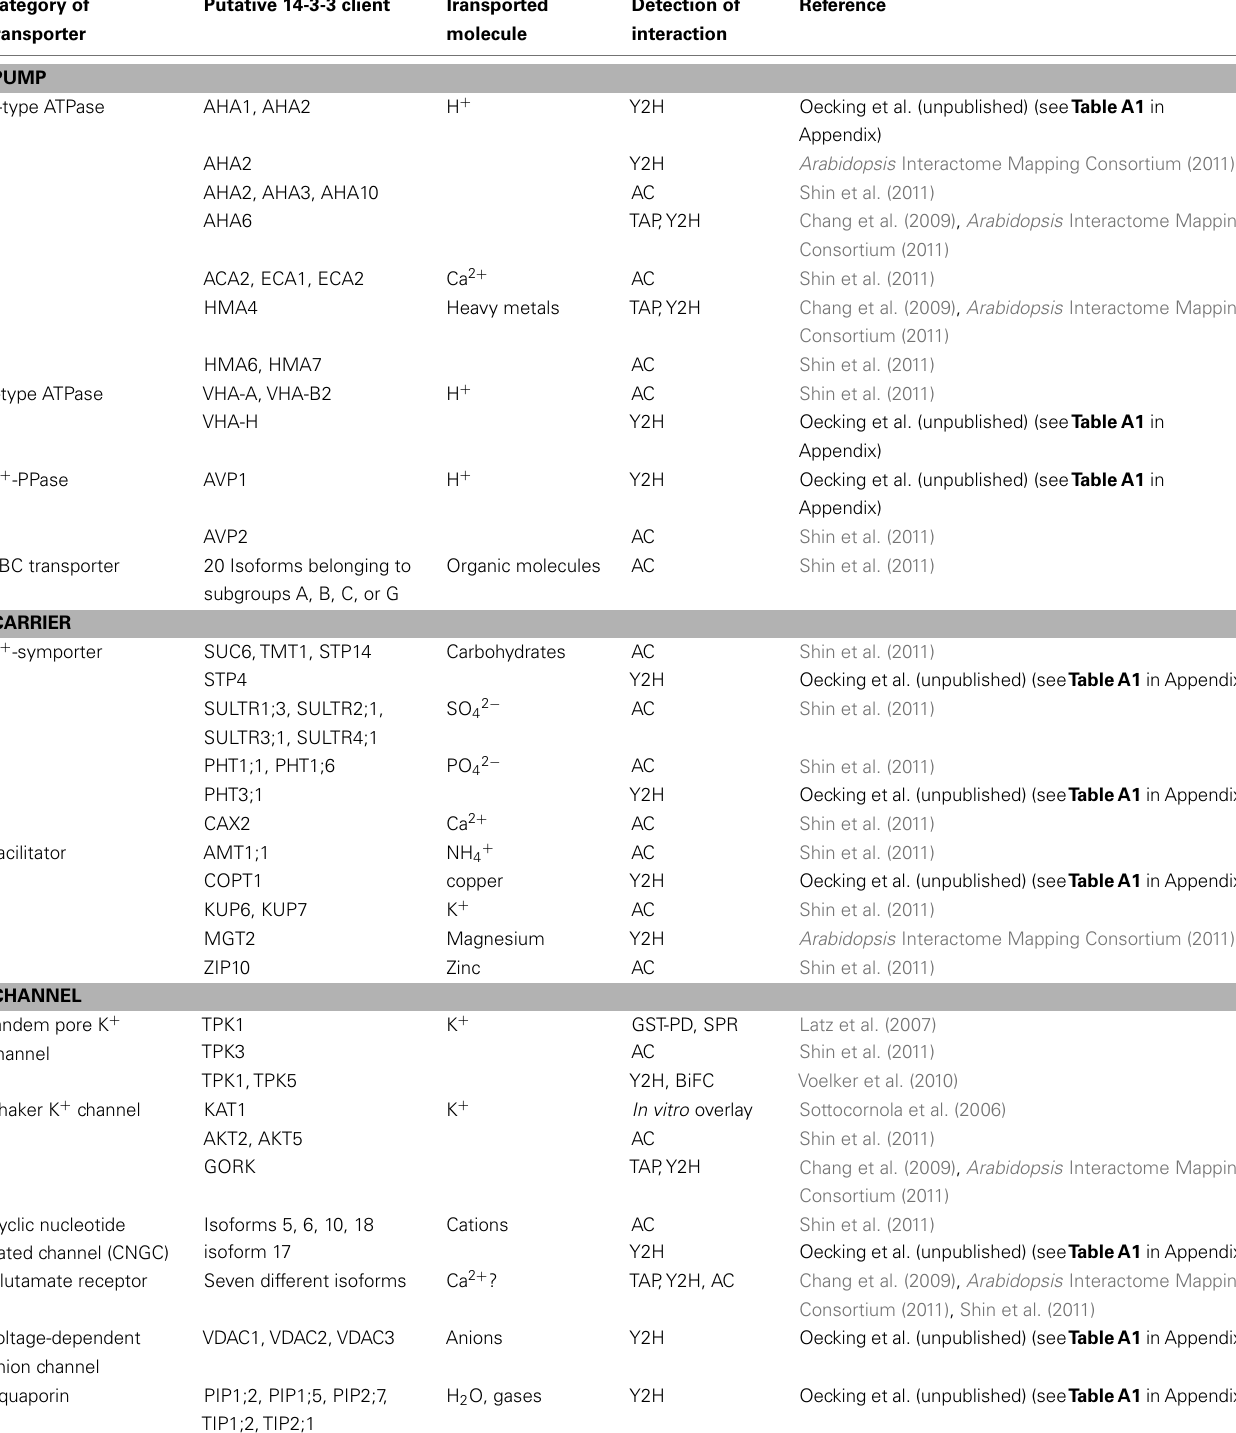
Table 1 |A summary of prominent membrane transporters recently identified as putative Arabidopsis 14-3-3 interactors. Category